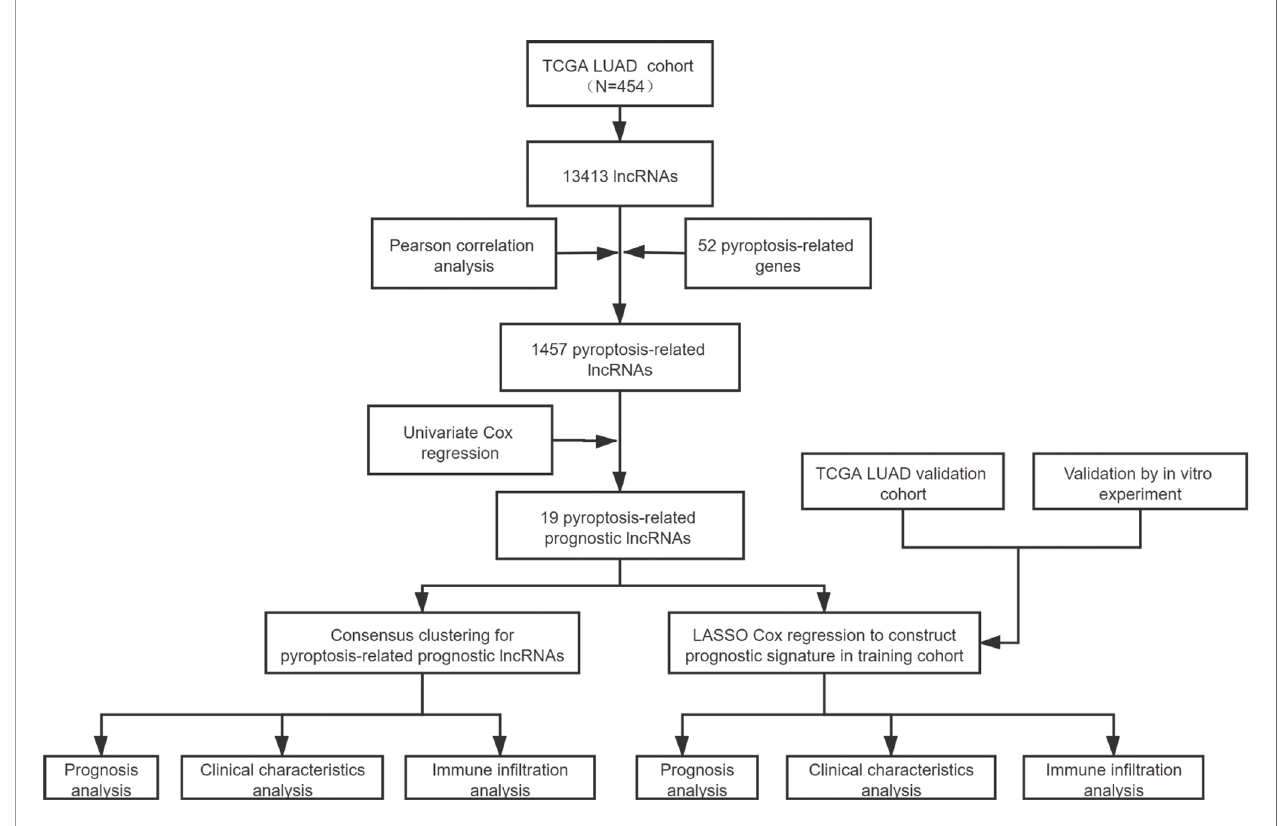
FIGURE 1 | The entire analytical process of the